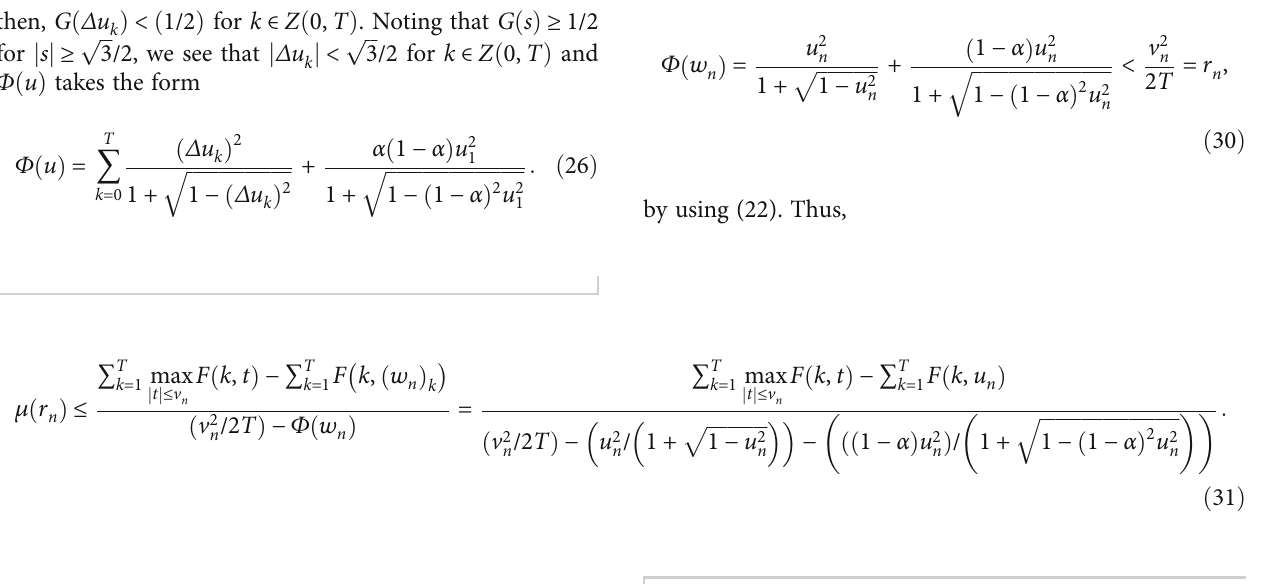
ffiffiffiffiffiffiffiffiffiffiffiffiffiffiffiffiffiffiffiffi ffiffiffiffiffiffiffiffiffiffiffiffiffiffiffiffiffiffiffiffiffiffiffiffiffiffiffi